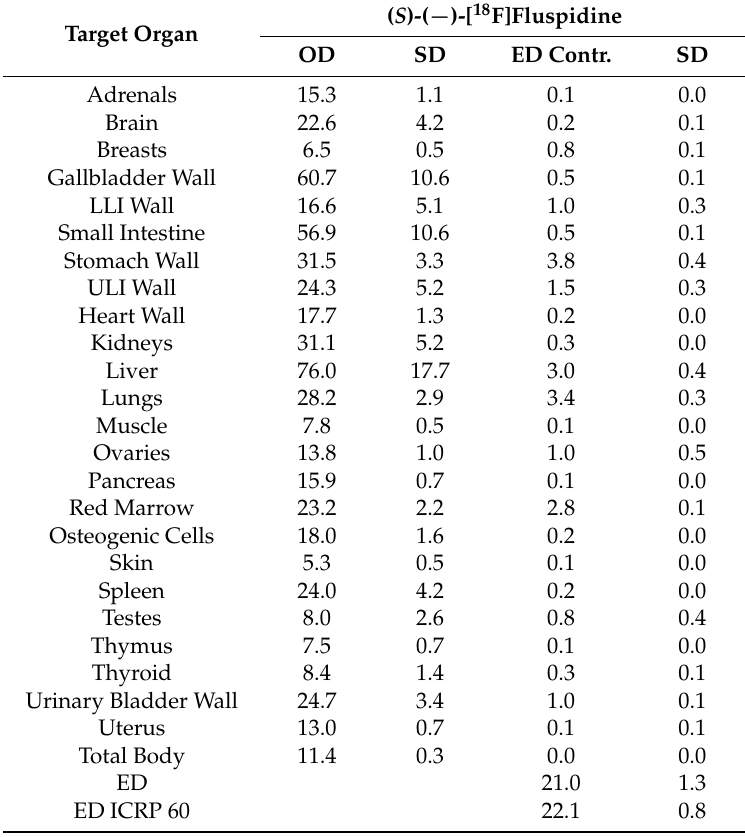
Table 3. First-in-human data, OD and ED in µ Sv/MBq. The ODs were calculated for the adult male model (73.7 kg, implemented in OLINDA) based on human biodistribution and organ geometry data.